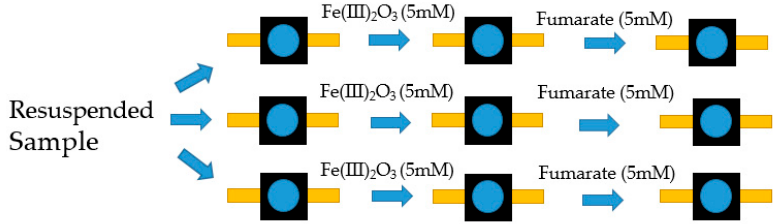
Figure 11. Schematic of the sampling process used for Chemostat grown biomass Raman measurements.